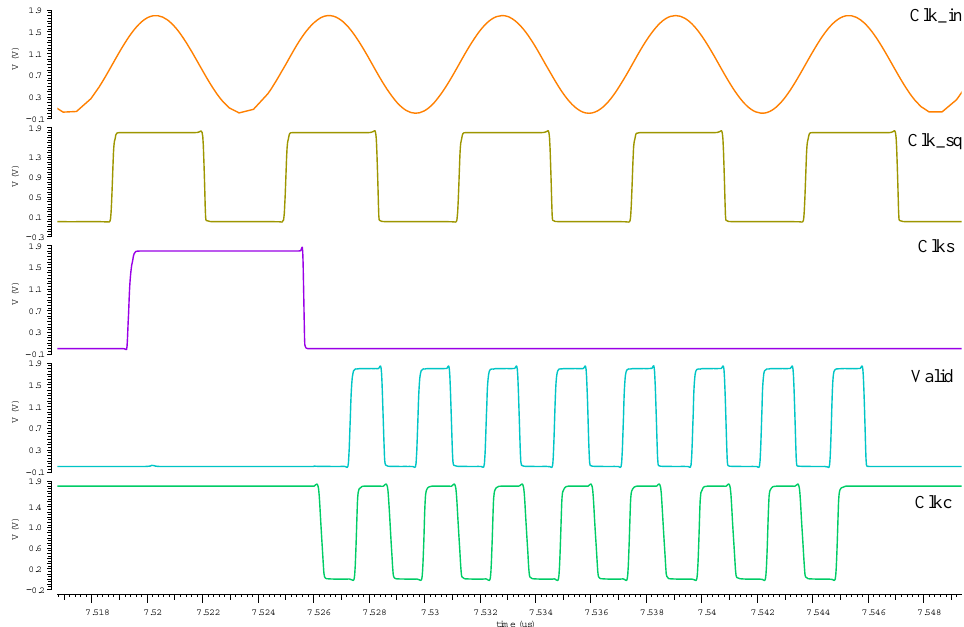
Figure 16. The simulated clock diagram of the proposed